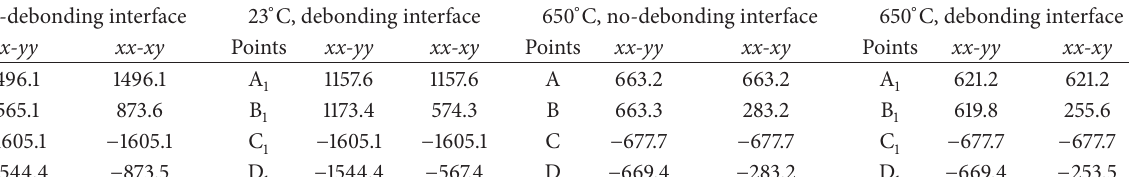
Table 2: The failure stresses of the [ 0/90 ] 𝑠 composite laminates (Mpa).